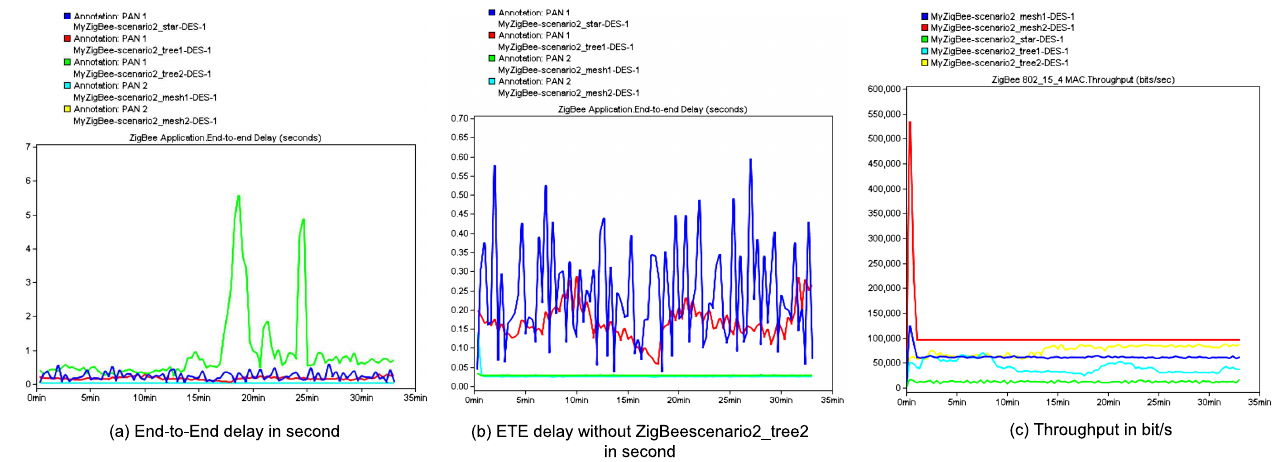
Figure 5. Set of results from scenario 2 with 50